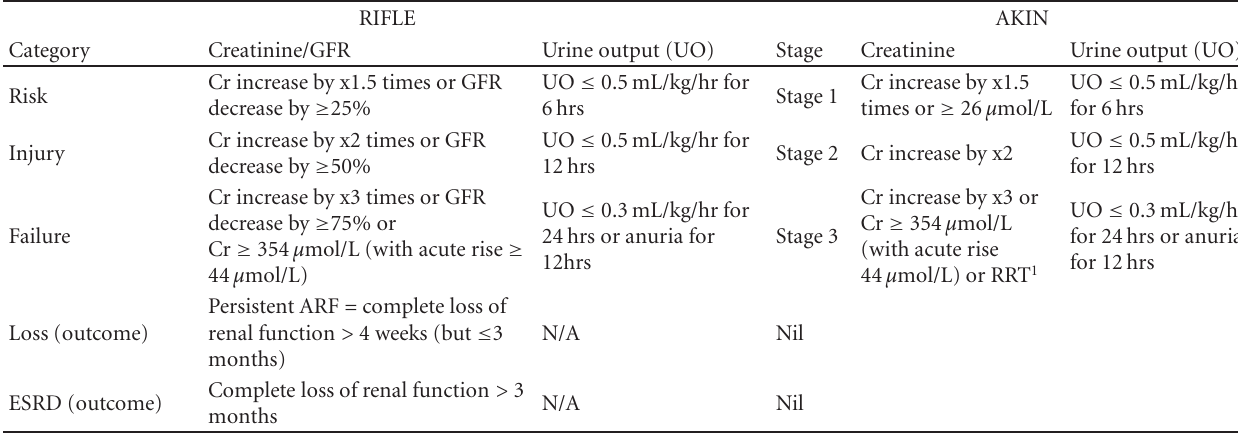
Table 1: RIFLE and AKIN classification [1,